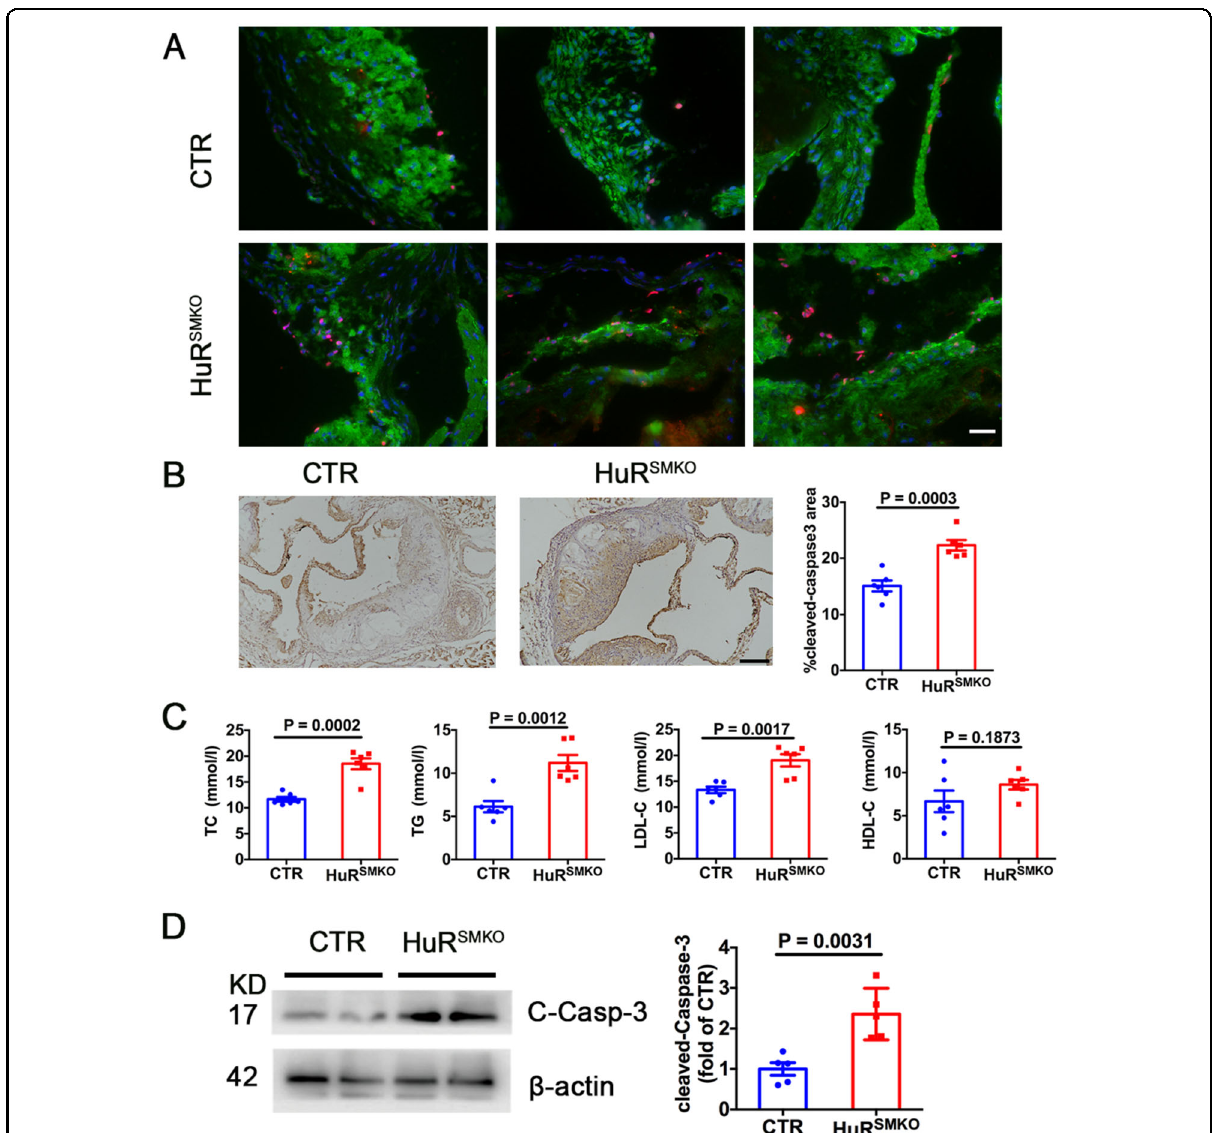
Fig. 3 Loss of HuR promoted apoptosis in atherosclerosis. A Immuno fl uorescent staining of aortic roots from CTR and HuR SMKO mice to determine TUNEL-positive VSMCs. Red puncta denotes TUNEL-positive cells. Green region denotes α -SMA. Scale bar = 20 μ m. B Immunohistochemical staining of cleaved caspase-3 in aortic roots ( n = 6). Scale bar = 50 μ m. C Serum lipid pro fi les (total cholesterol [TC], triglycerides [TG], high-density lipoprotein cholesterol [HDL-C], and low-density lipoprotein cholesterol [LDL-C]) ( n = 6). D Western blot analysis of cleaved caspase-3 in control and HuR-de fi cient SMCs ( n =